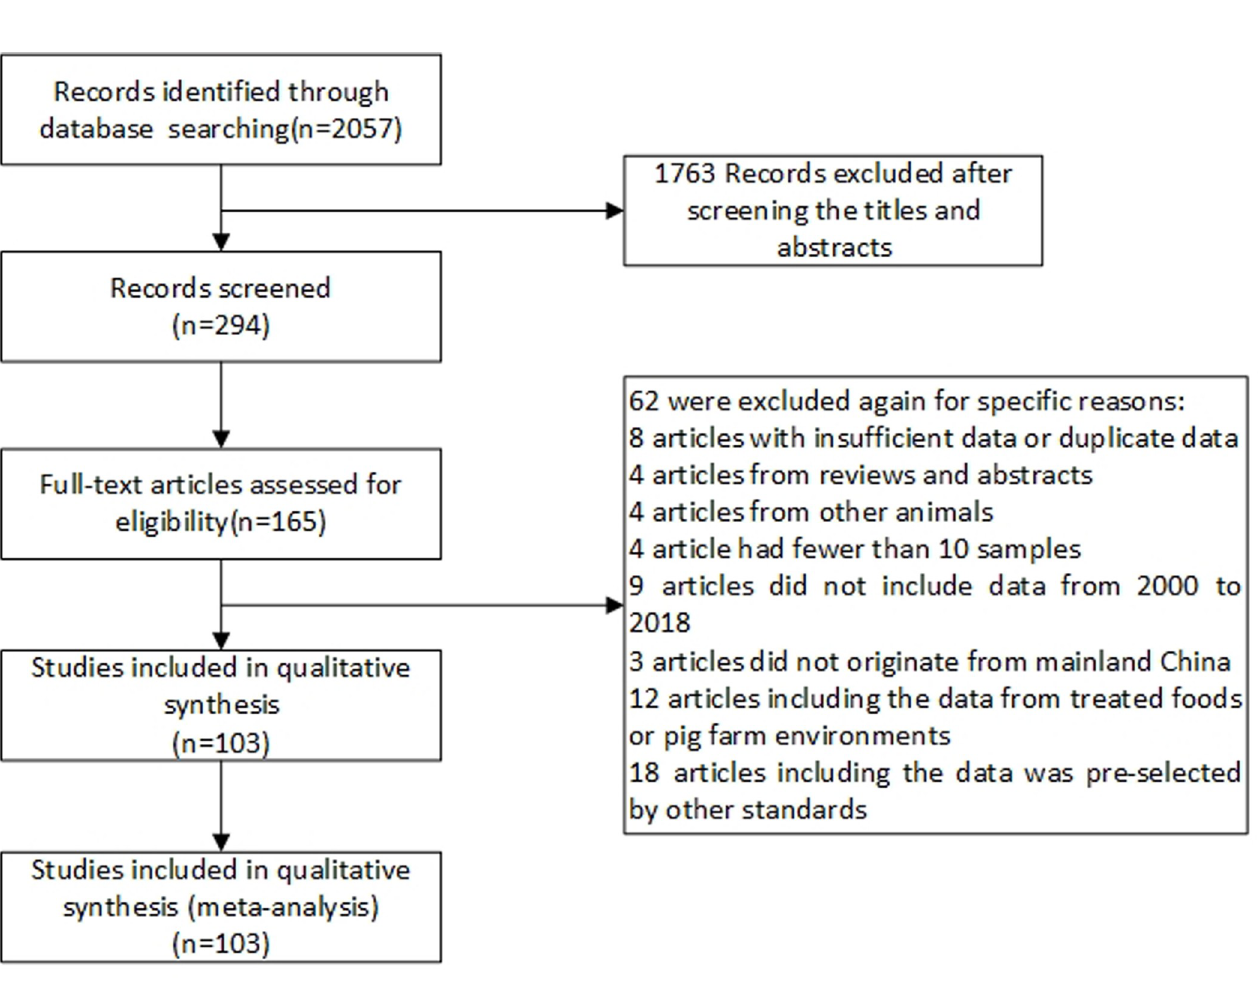
Fig 1. PRISMA flow diagram. Flow chart depicting the study selection